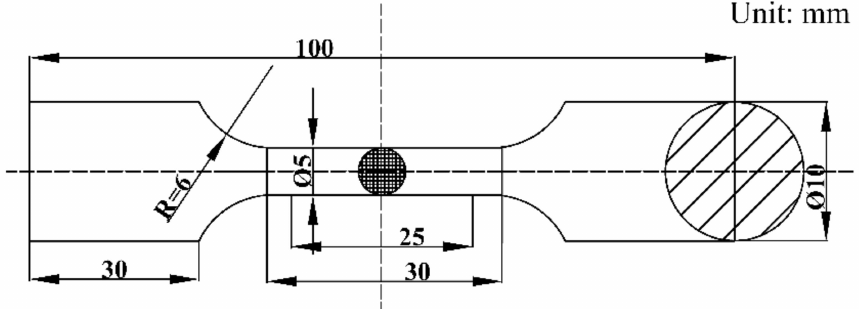
Figure 2. The schematic diagram of the tensile sample with two-dimensional